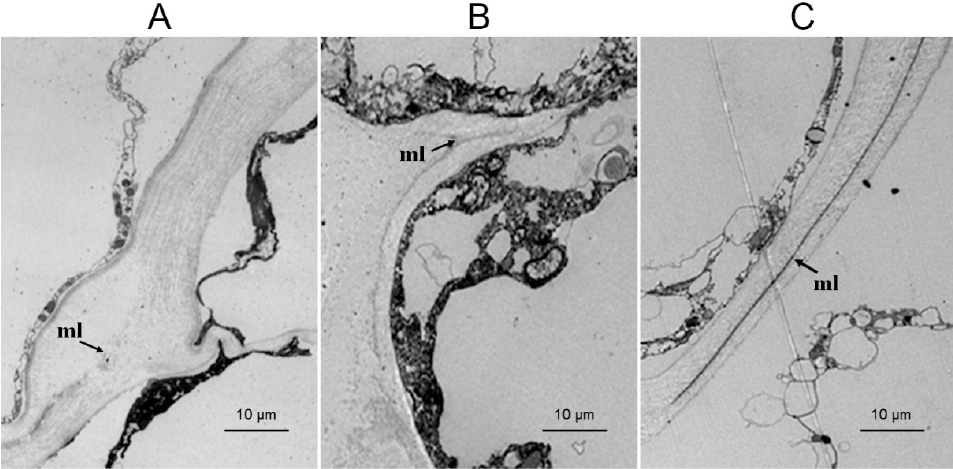
Figure 2. Transmission electron microscopy images of raspberry fruit of the control ( A ), CaCl 2 ( B ) and CaCl 2 +PME ( C ) treatments stored at 4 °C for 9 days. ml: middle lamella.